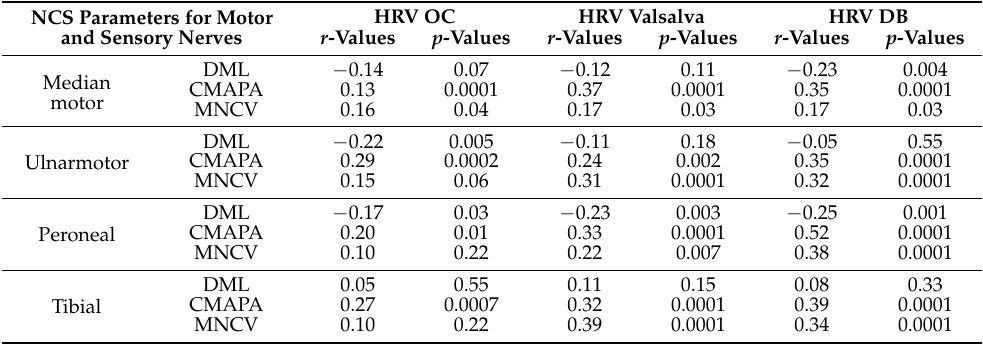
Table 3. Results of correlations between electrophysiological parameters of motor nerve function and HRV tests.